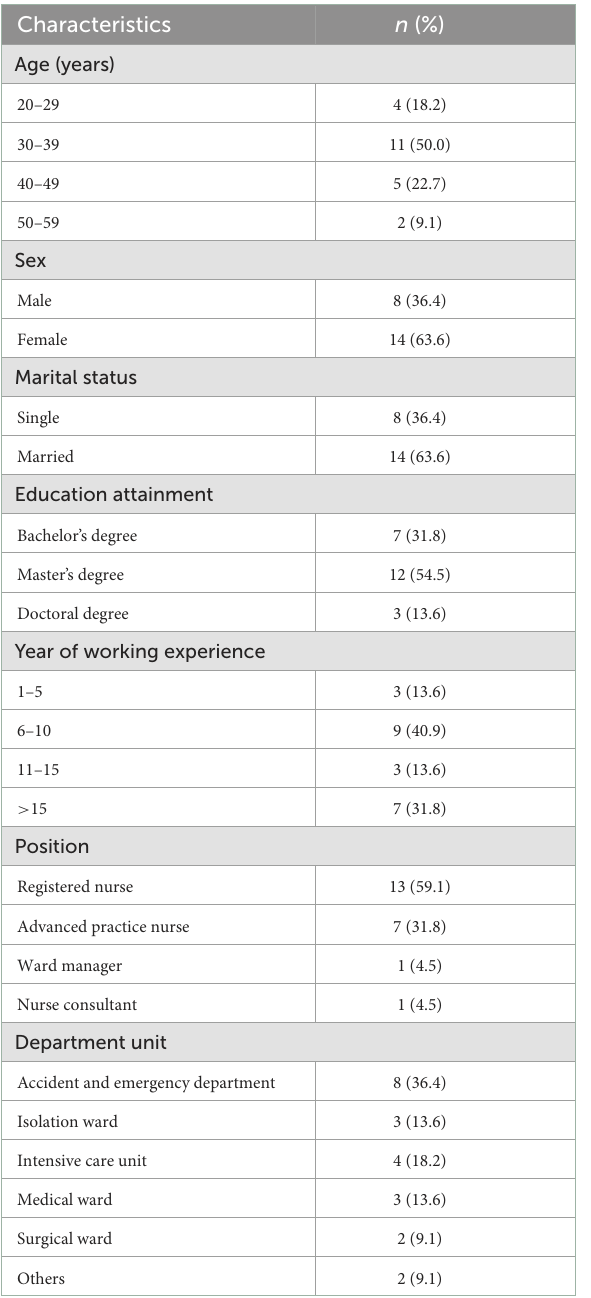
TABLE 1 Participants’ demographic and work characteristics.